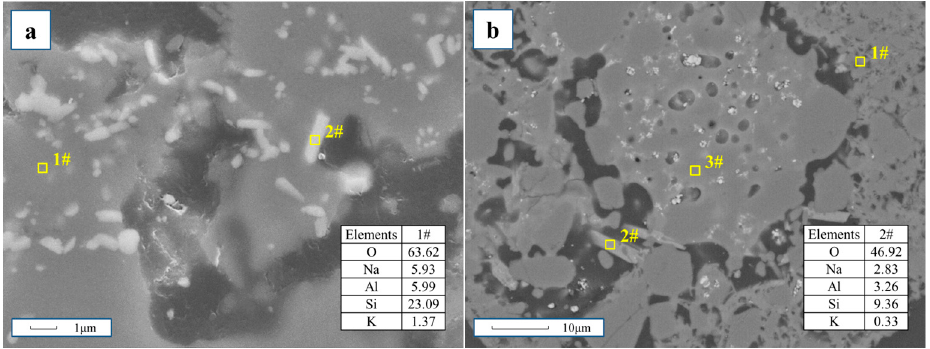
Figure 4. The SEM pattern of NaCl-Na 2 CO 3 composite salt leaching residue. ( a ) Melt and the white particles therein, ( b ) The melting part of ore. 1#—melt, 2#—albite, and 3#—quartz. This indicates that V(III) is rapidly oxidized to V(IV) with the destruction of mica lattice after the removal of hydroxyl. While V(IV) exist in the newly-formed melt of K-Al-Si-O. V(IV) continues to oxidize and reacts with the additive to form the vanadate. The eutectic temperature between NaCl and Na 2 CO 3 is 908 K. During the roasting process (1073 K), the contact area between NaCl-Na 2 CO 3 molten salt and mineral particles increases. The migration rate of ions in molten salt also increases. This accelerates the formation of vanadate and the ion exchange between Na and K. As the potassium